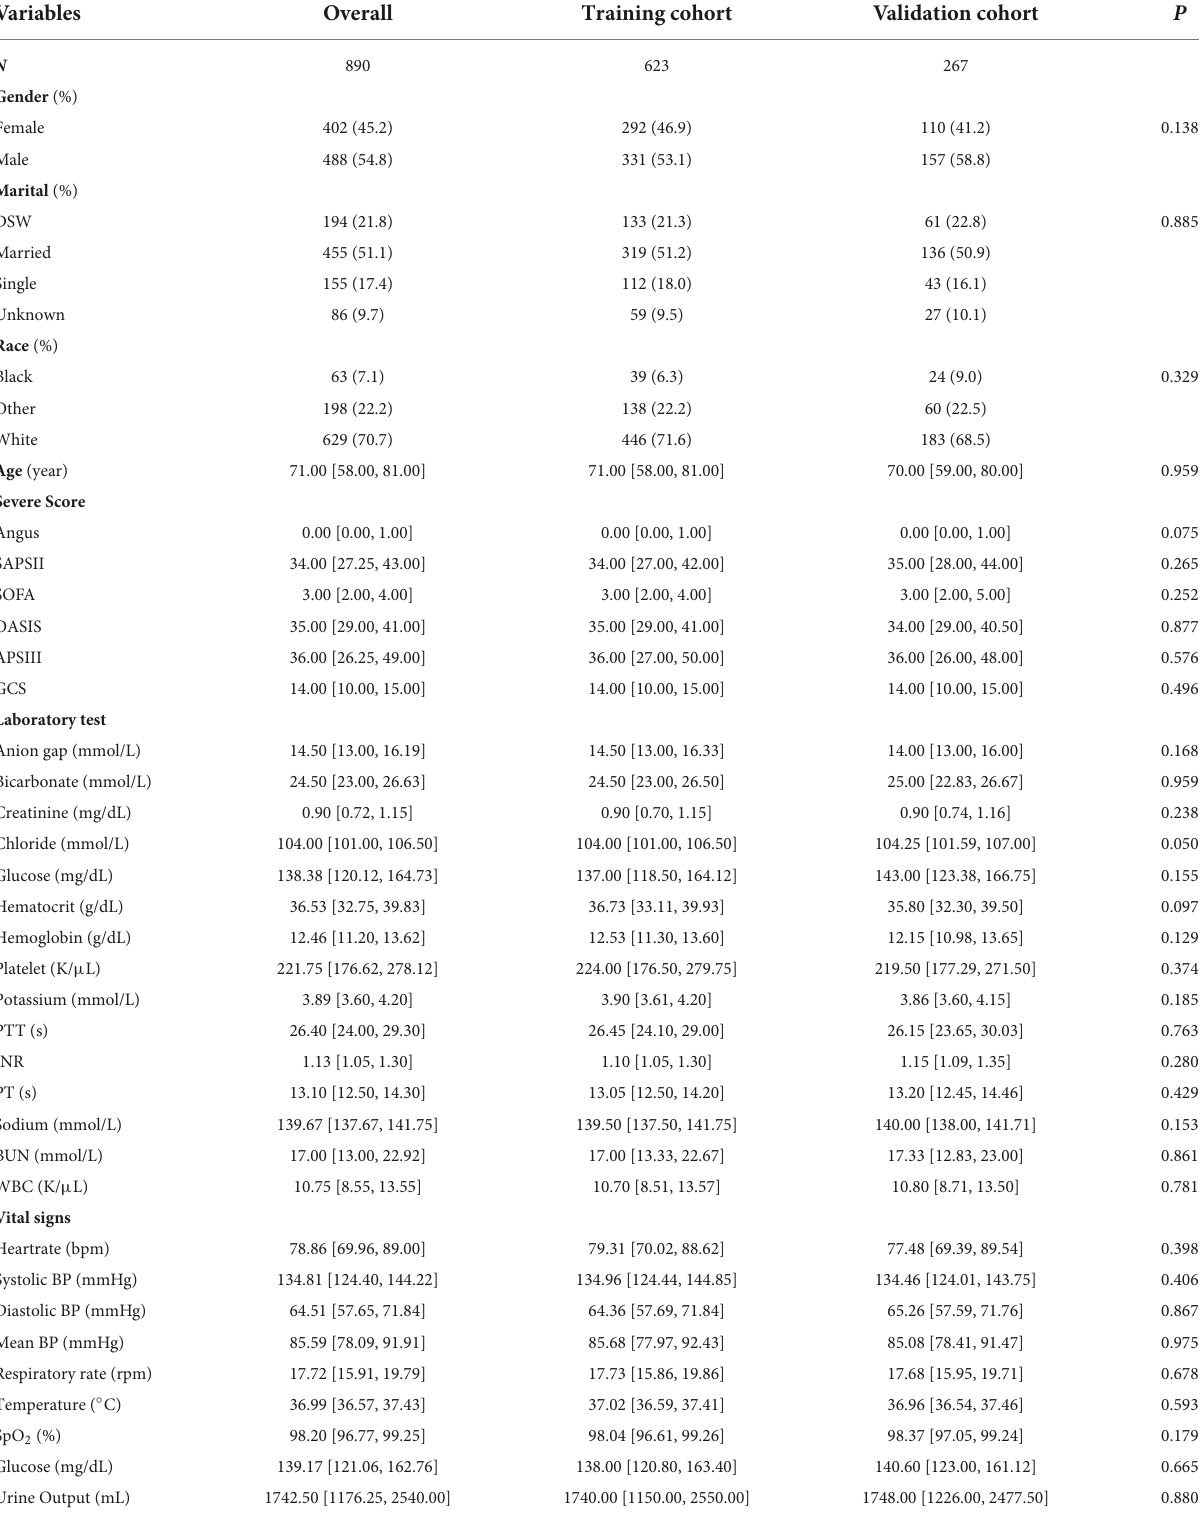
TABLE 1 Patient